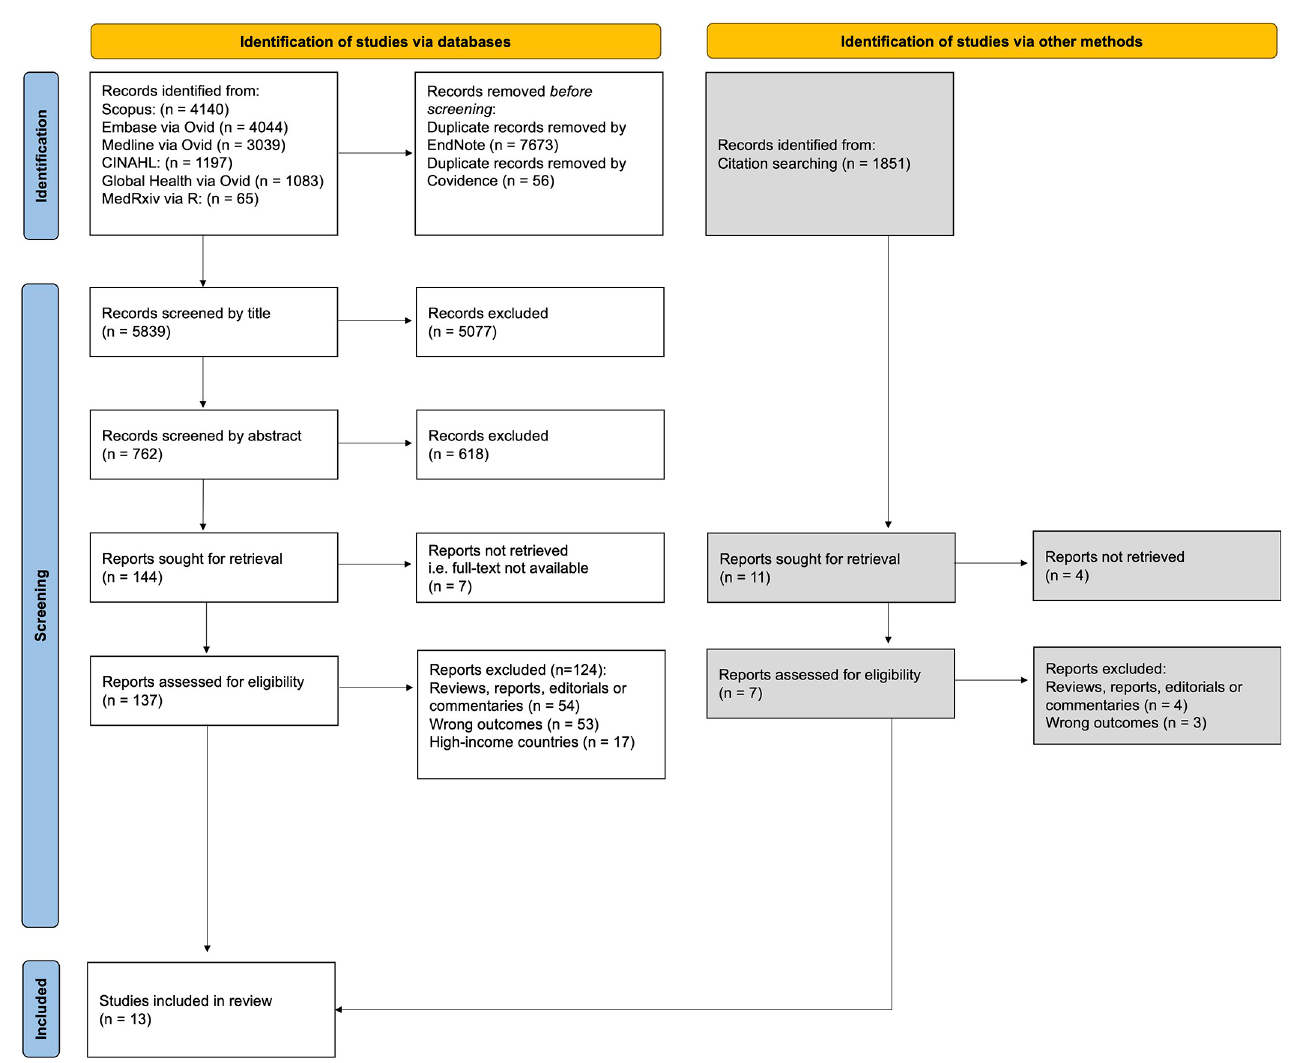
Fig 1. PRISMA flowchart outlining identification and screening process for studies included in the